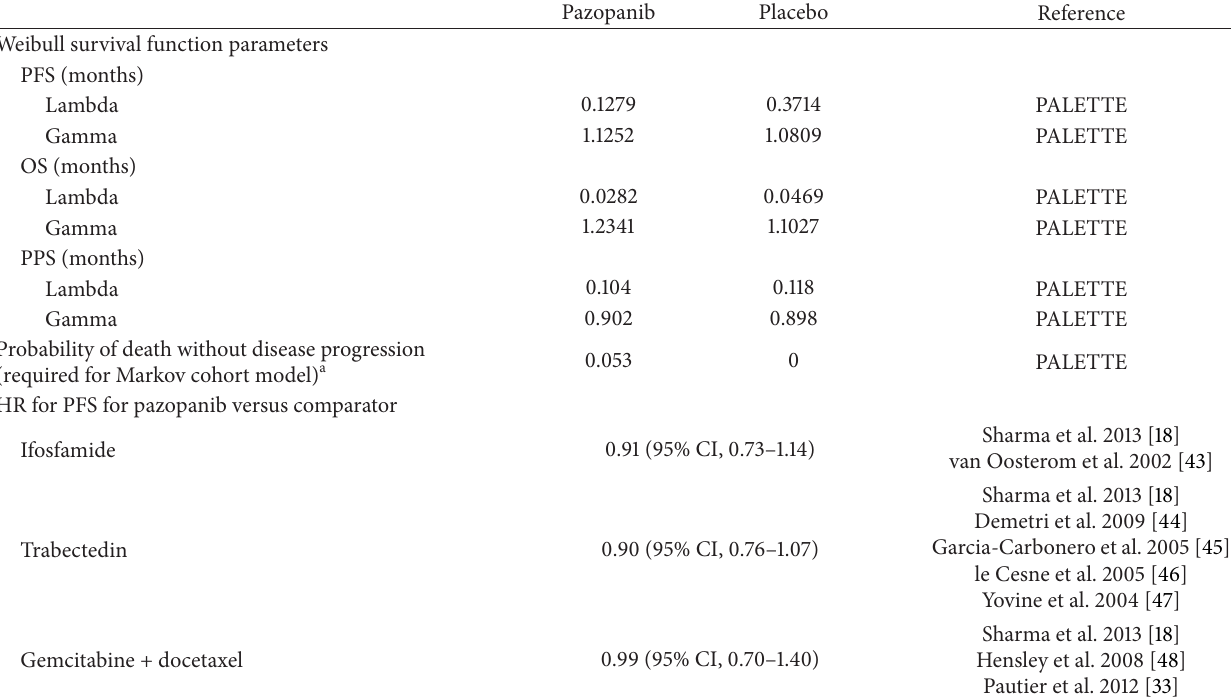
Table 1: Survival distribution